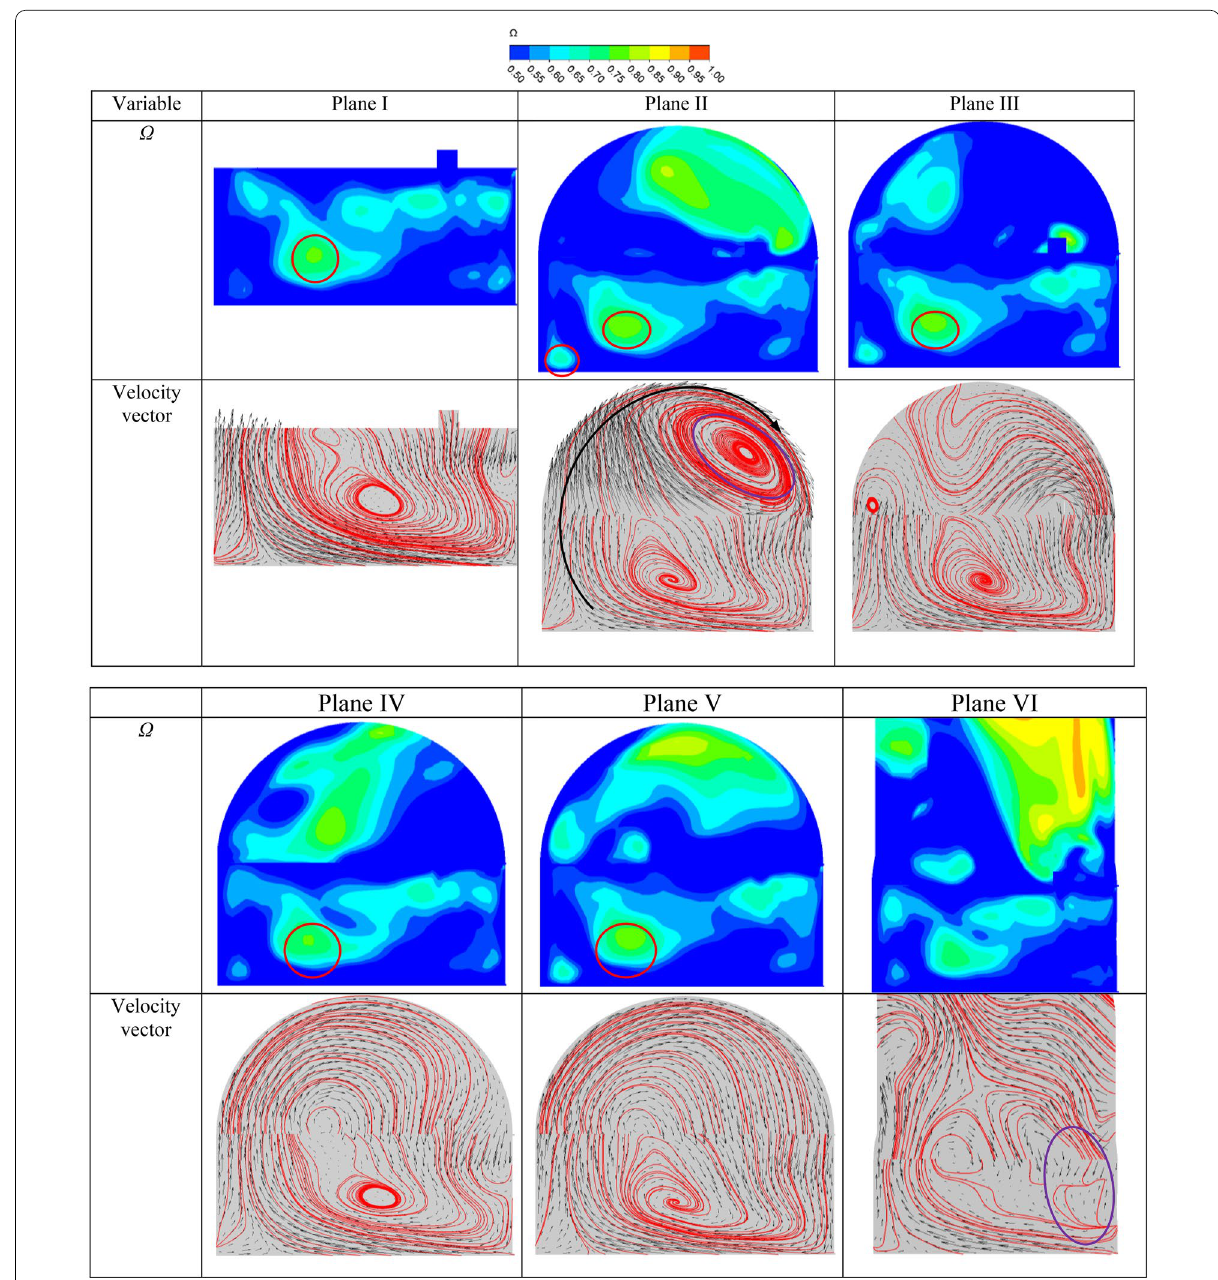
Figure 13 Distributions of vortex intensity and velocity vector plots on longitudinal